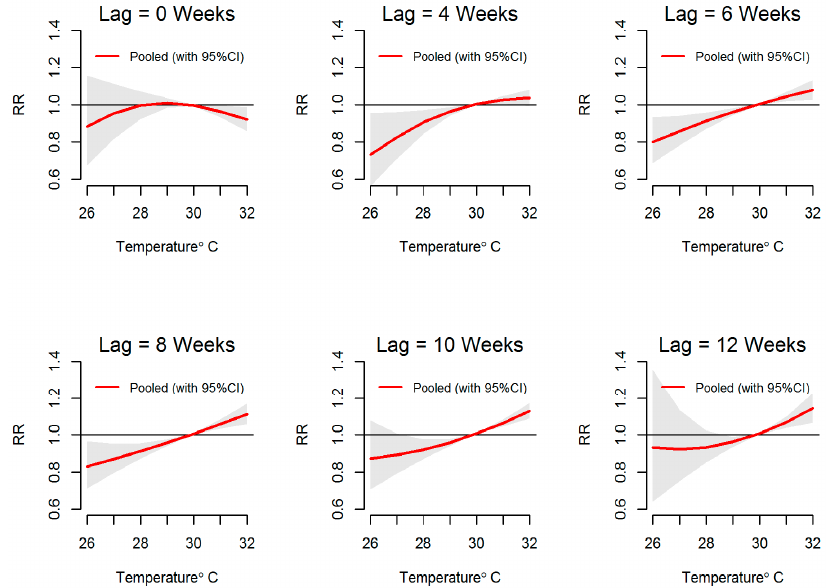
Figure 8. Relative risk (RR) of dengue by weekly mean temperature at specific lags in 10 MOH divisions in Kalutara district, Sri Lanka, 2009–2013. The figure illustrates the predicted curves from meta-regression for different lag periods; 0, 4, 6, 8, 10 and 12 weeks. The shaded areas represent 95% confidence intervals. Reference value is at 29.8 °C.